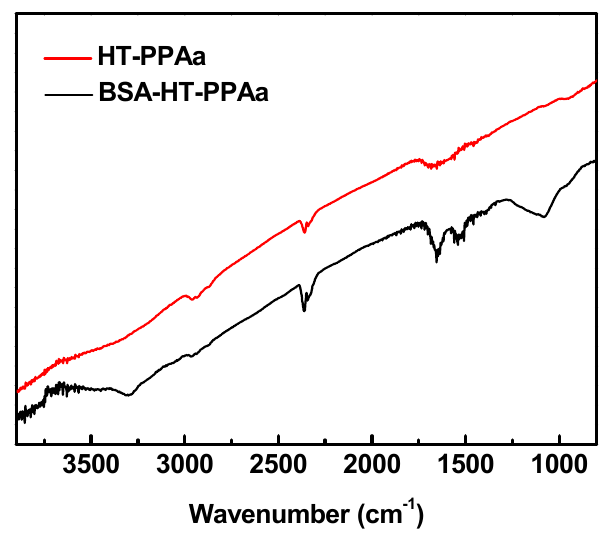
Figure 8. FTIR results of HT-PPAa film and BSA-HT-PPAa film.